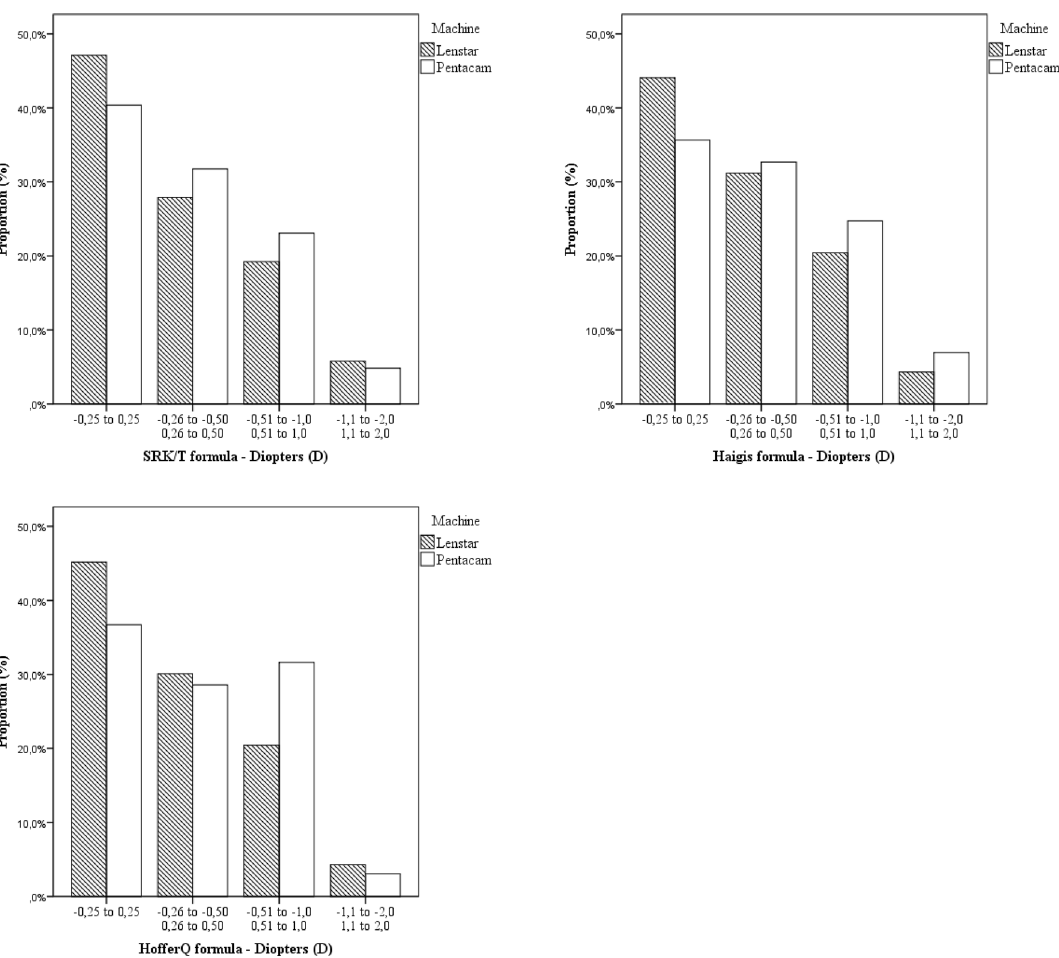
Figure 1. Proportion of eyes whose postoperative refraction differed from preoperative predicted refraction as determined by the Lenstar and the Pentacam with SRK/T, Haigis and Hoffer Q